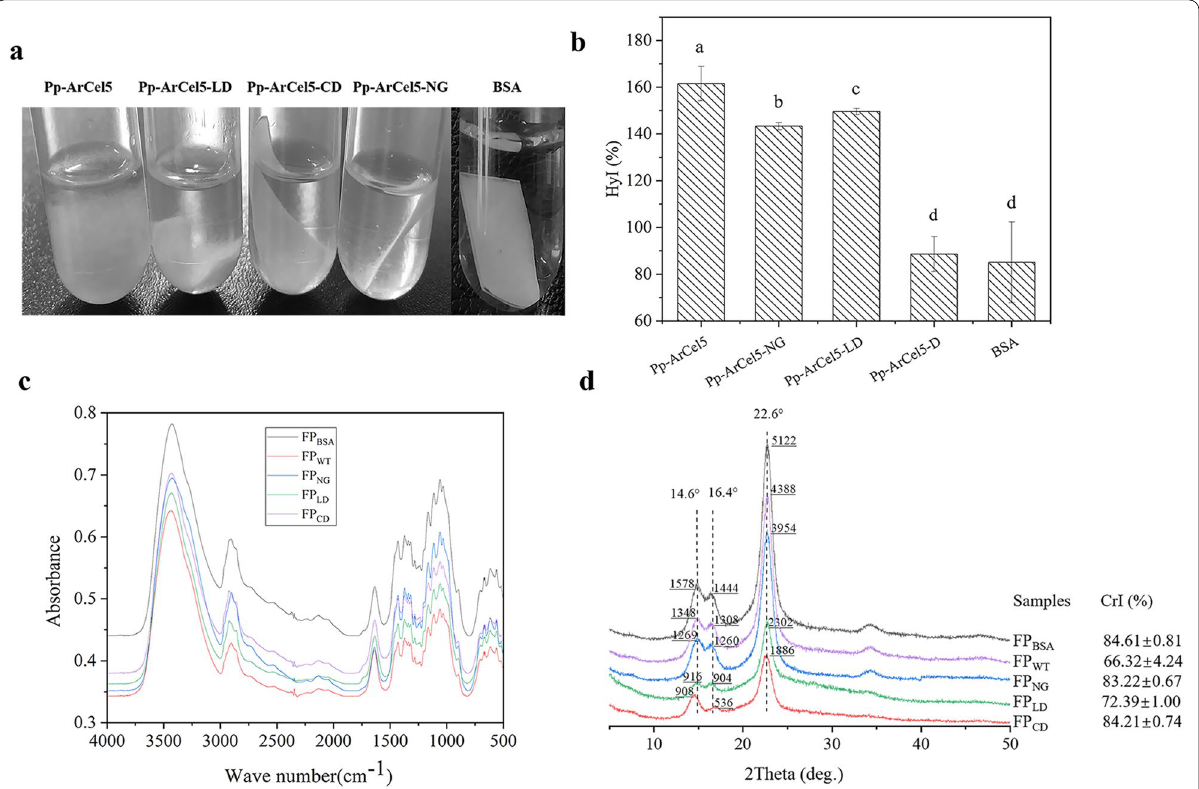
Fig. 5 Summarized properties of filter paper after being treated by different solutions. a Filter paper was deconstructed by ArCel5 mutants. Pp-ArCel5, Pp-ArCel5-NG, Pp-ArCel5-D or BSA acted on filter paper for 48 h to observe disruption. The filter paper with a size of 1 cm incubated in 50 mM acetic acid–sodium acetate buffer (pH 5.0), containing 0.5 g/L ArCel5 mutants or BSA at 55 ℃ for 24 h. b The hydrature index of filter paper after being treated by ArCel5 mutants and BSA. The different letters mean significant difference, during the same letter means no significant difference. The final concentration of filter paper with 40 g/L was incubated in 50 mM acetic acid–sodium acetate buffer (pH 5.0) containing 0.5 g/L ArCel5 mutants or BSA at 55 ℃ for 24 h. c FTIR spectroscopy spectrum of the filter paper after being treated by the ArCel5 mutants or BSA. d The X-ray diffraction spectrum imbibed of the filter paper after being treated by ArCel5 mutants and